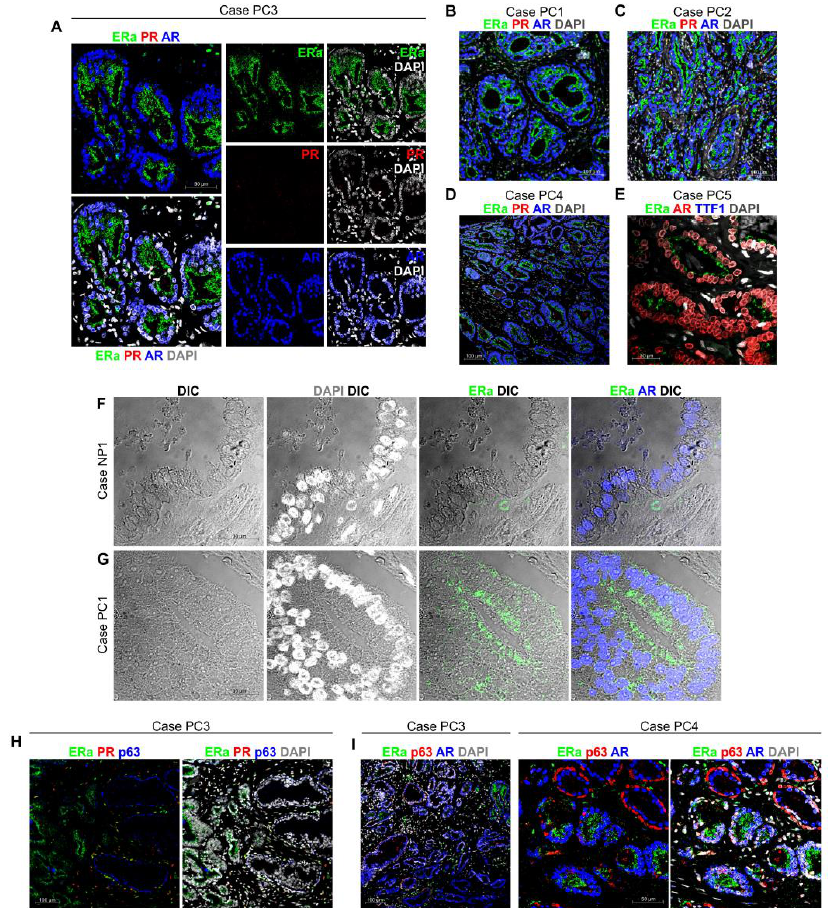
Figure 6. ColNu mIHCF in prostate cancer reveals ERa at the apical membrane of cancer epithelium. ( A ) ColNu mIHCF for all three nuclear receptors in PC1 showing each separate channel (center) and the overlays among them (left) or with DAPI (right). Prostate cancer epithelium expresses AR (blue) in the nucleus, but ERa (green) on the apical membrane. PR is not expressed. ( B – D ) Lower magnifications reveal the same pattern of nuclear AR and apical membrane ERa co-expression in PC1 ( B ), PC2 ( C ), and PC4 ( D ). ( E ) Similar staining with different order and TSA for AR, again exhibits nuclear AR (red) and apical membrane ERa (green) co-expression in the cancer epithelium of case PC5. TTF1 staining was negative. ( F , G ) A phase contrast plane (DIC) is shown for paired samples of case NP1/PC1 alone or overlaid with other channels. A single basal ERa cell is shown underneath the normal prostate epithelium expressing nuclear AR in NP1 ( F ). The whole prostate cancer epithelium co-expressing nuclear AR and apical membrane ERa is shown in PC1 ( G ). ( H ) At lower magnifications (case PC3), the combination of p63 and ERa demarcate prostate cancer from normal prostate tissue. On the left, prostate cancer with ERa located on the apical membrane. On the right, normal prostate epithelium with the p63 basal layer displaying some p63/ERa double positive cells. PR is expressed at the stroma. ( I ) The same result was obtained for PC3 and PC4. While AR is located in the nucleus of both cancer and normal prostate epithelial cells, apical membrane ERa staining is specific for cancer, while p63 is conserved at the intact basal layer of normal prostate tissue. The order of antibodies in the consecutive cycles is indicated above each photograph. Pseudocolor was kept constant: green for the 1st, red for the 2nd, and blue for the 3rd cycle. DAPI was included in the mounting medium and reveals the nuclei. DIC is a plane obtained with transillumination for differential interfering contrast-Nomarski and reveals tissue structure).